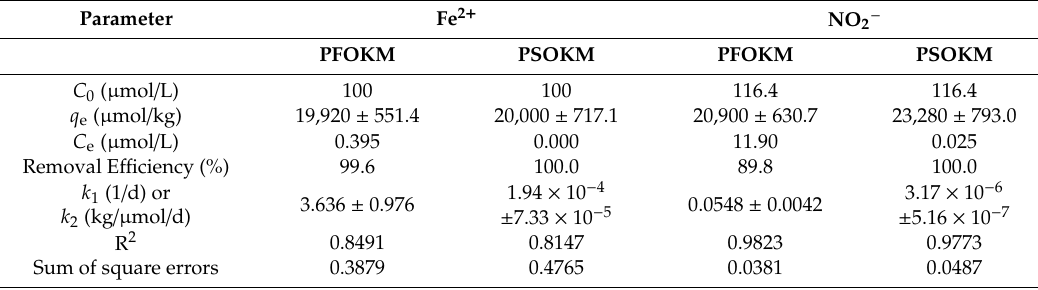
Table 2. Pseudo first order kinetic model (PFOKM) and pseudo second order kinetic model (PSOKM) parameters for the sorption of Fe 2 + at pH 7 and NO 2 − at pH